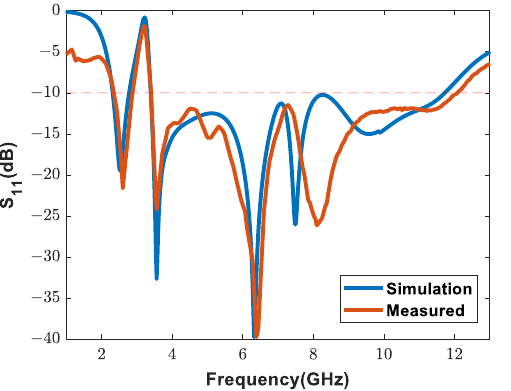
Figure 8. Comparison of the antenna S-parameters between measurement and simulation.